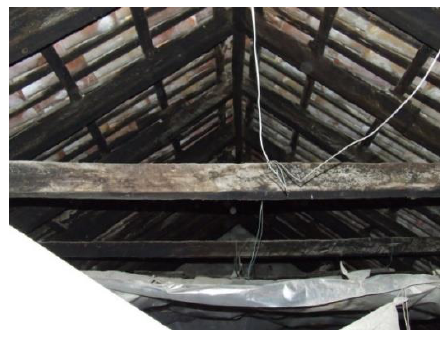
Figure 18. Hipped roof construction.